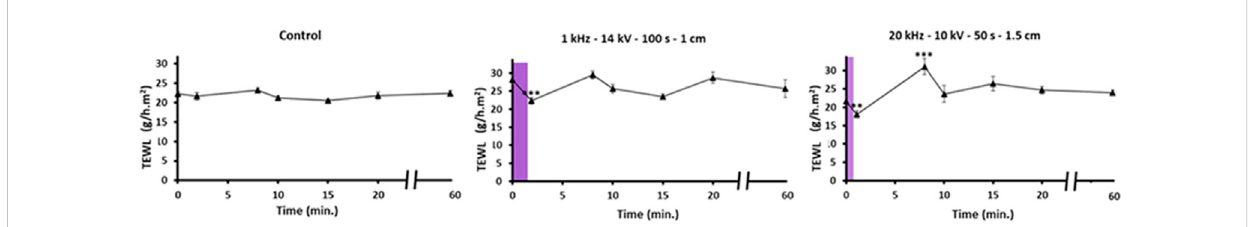
FIGURE 5 One-hourTEWLevolutionforleft:control,middle:1k100splasmaexposure,andright:20k50splasmaexposure.Thevioletbarsvisualizetheplasma treatment time.